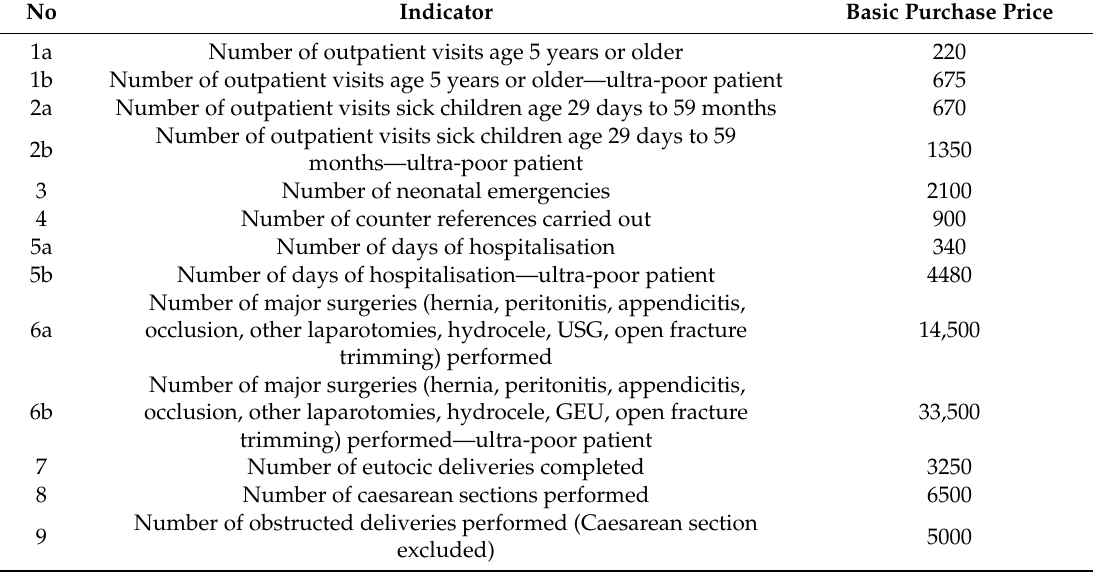
Table A2. List of Quantity Indicators Included in PBF Design